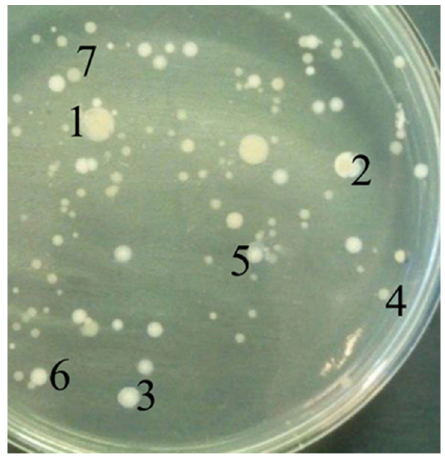
Figure 1. View of colonies selected for further work.